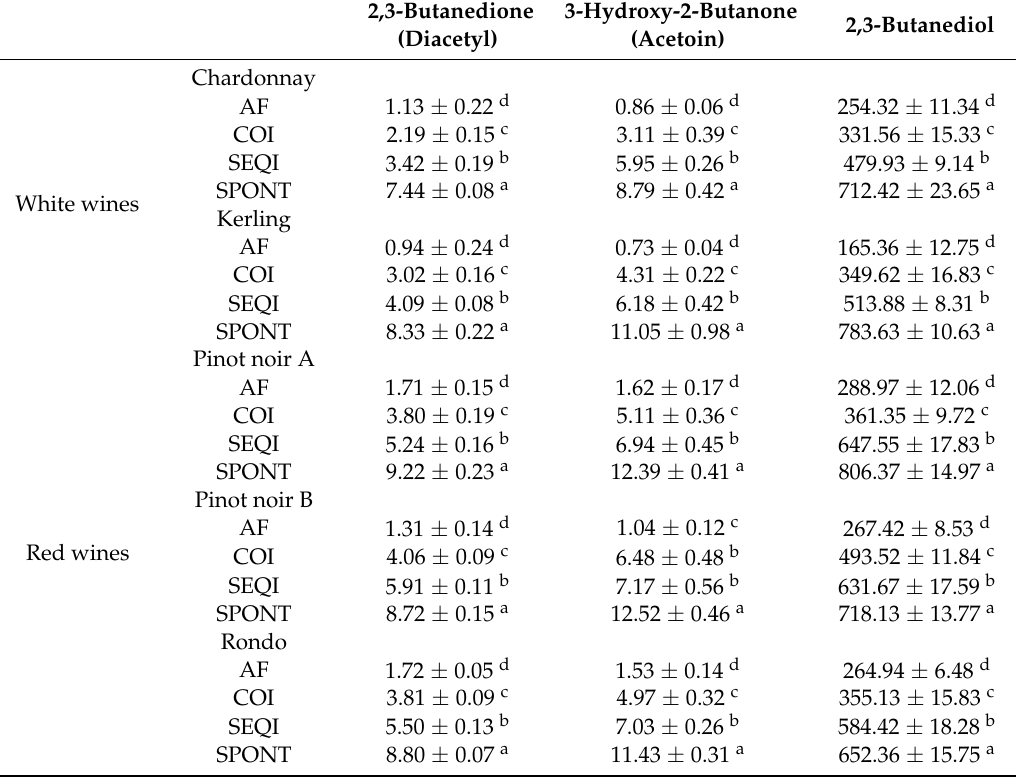
Table 4. Concentrations (mg/L) of diacetyl, acetoin, and 2,3-butanediol in white and red grape wines produced by different methods of MLF induction; parameters were evaluated three months after